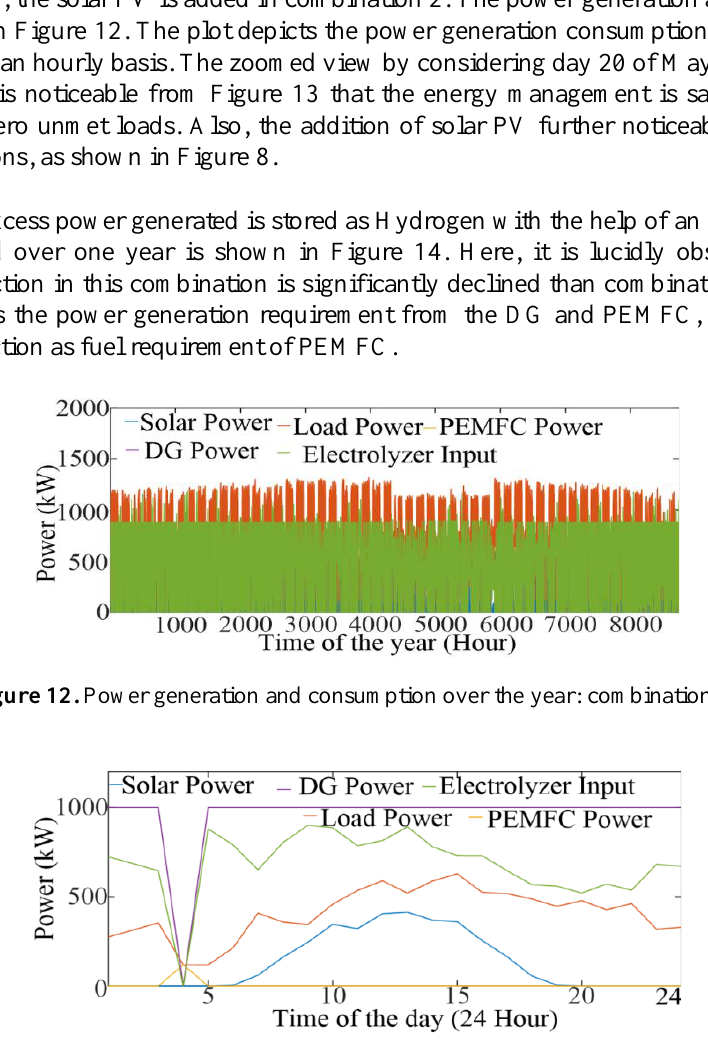
Figure 13. Power generation and consumption for one day: combination